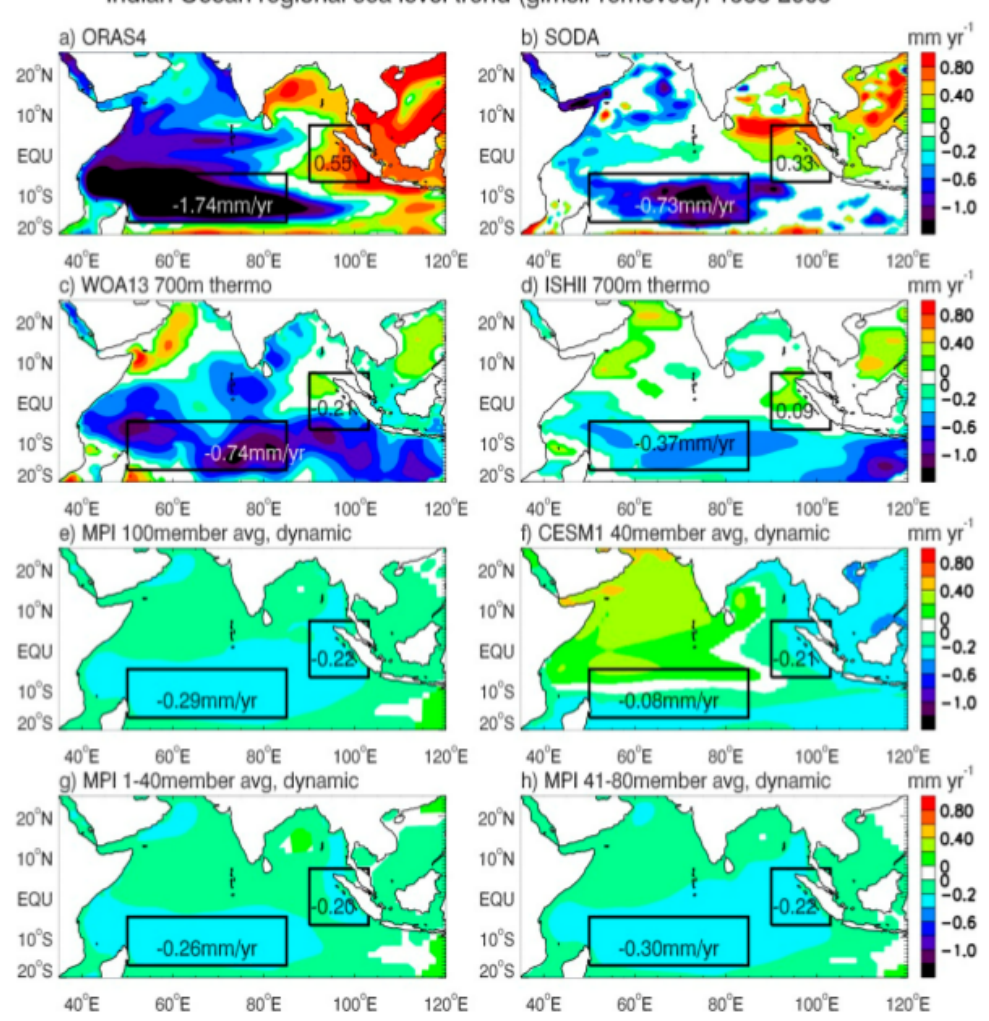
Figure 2. The linear trends of regional sea level over the tropical Indian Ocean from 1958–2005. Monthly data are used, with the 1958–2005 monthly climatology and global mean sea level rise (SLR) time series removed from each dataset before the trend calculation. ( a ) The ECMWF Ocean Reanalysis System 4 (ORAS4) reanalysis; ( b ) the Simple Ocean Data Assimilation (SODA) reanalysis; ( c ) the world ocean atlas 2013 (WOA13) upper 700 m thermosteric sea level; ( d ) Ishii upper 700 m thermosteric sea level; ( e ) the Max-Planck-Institute of meteorology (MPI) 100-member ensemble mean dynamic sea level; ( f ) the National Center for Atmospheric Research (NCAR) community earth system model version 1 (CESM1) 40-member ensemble mean dynamic sea level; ( g ) MPI ensemble mean for members 1–40; ( h ) MPI ensemble mean for members 41–80. The two boxes show the maximum sea level fall and rise areas in both the ORAS4 and SODA dynamic sea level, with Reg. 1 located in the thermocline ridge of the southwest tropical basin (50 ◦ E–85 ◦ E, 17 ◦ S–5 ◦ S) and Reg. 2, eastern equatorial Indian Ocean (90 ◦ E–103 ◦ E, 7 ◦ S–7 ◦ N). The number in each box shows the trend value of SLA averaged in the box. Trend values exceeding 95% significance are shown in color contours, and those below 95% are shown in